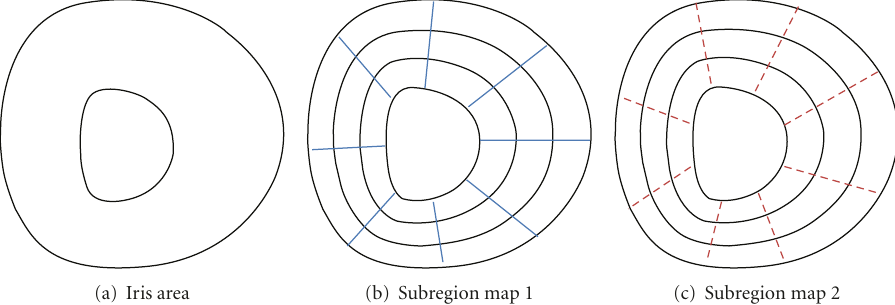
Figure 1: Demonstration of the iris subregion selection. (Note that there are more subregions than shown here.) The subregion map 2 is about half angular resolution shifting of subregion map 1.